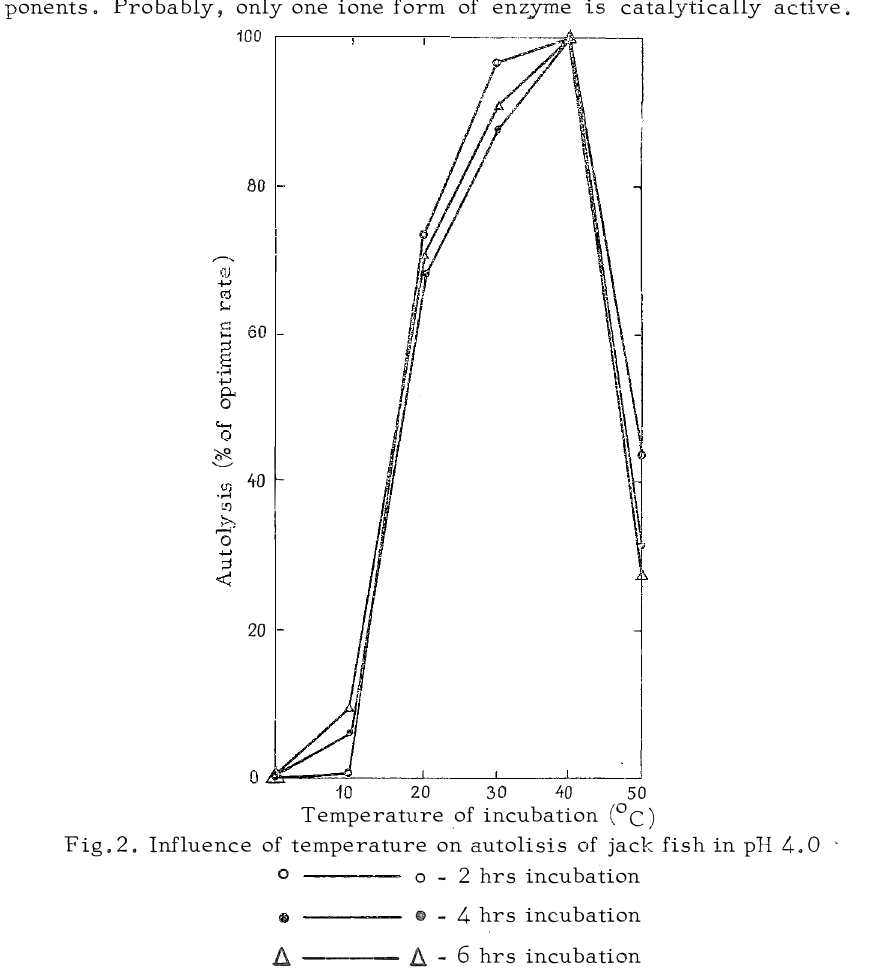
Fig.2. Influence of temperature on autolisis of jack fish in pH